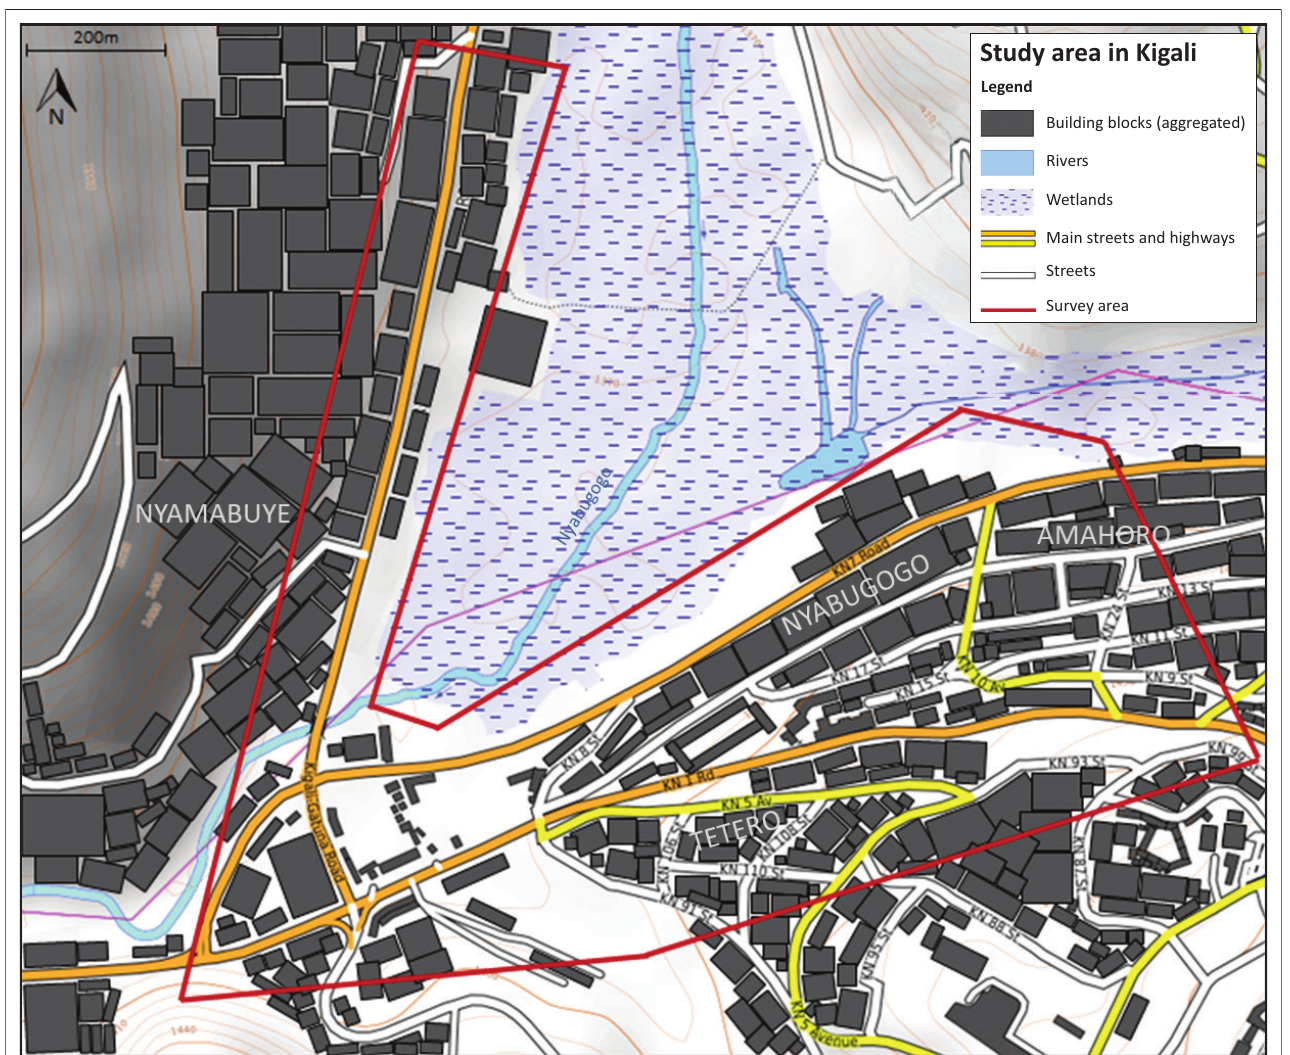
FIGURE 1: Map of the surveyed area. Map credits: © OpenStreetMap-contributors (SRTM); Map design: © OpenTopoMap (CC-BY-SA), changes made: Buildings added, individuals buildings are aggregated, area encircled in red shows surveyed